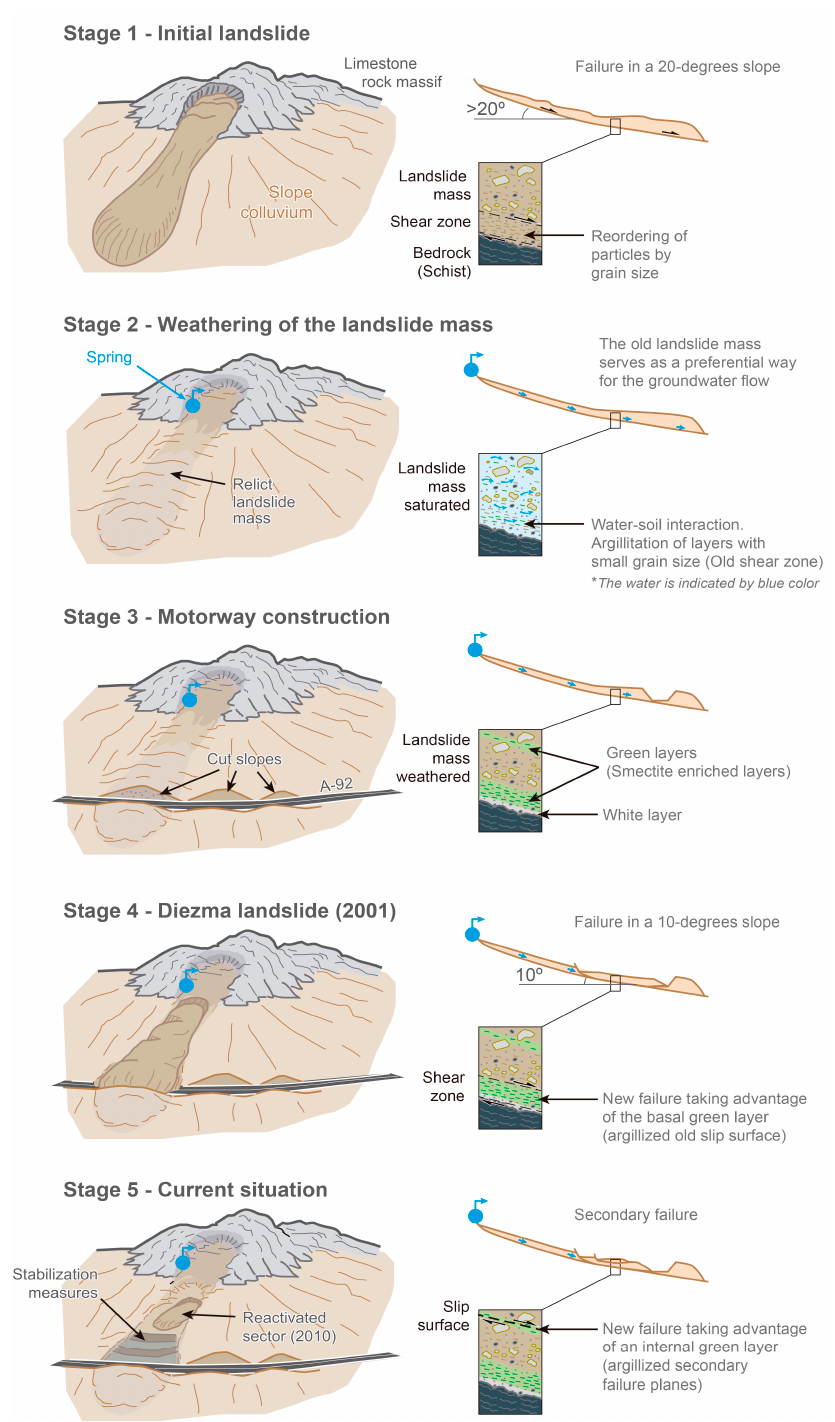
Figure 13. Conceptual model of the Diezma landslide’s evolution from the initial state until the current situation.